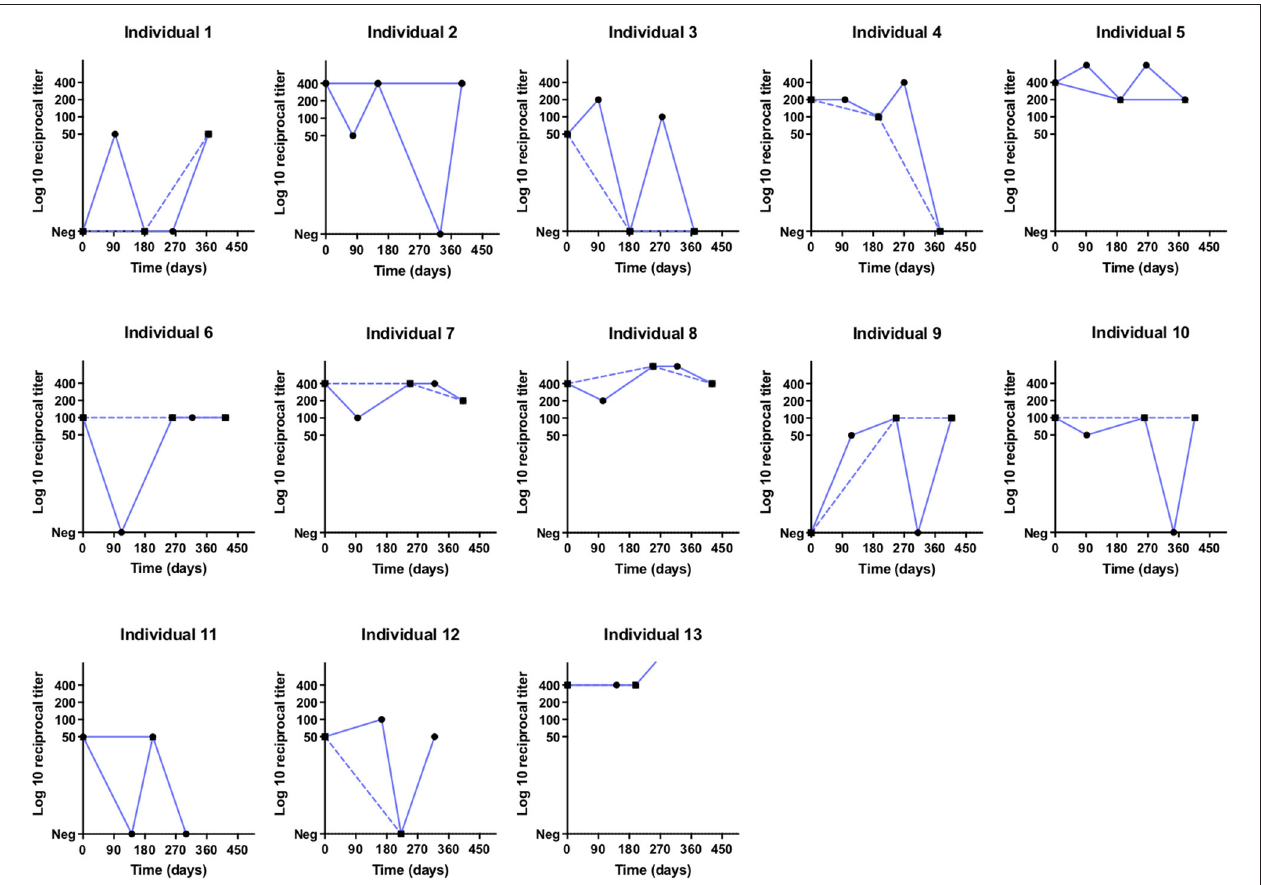
FIGURE 3 | Titration curves in log10 of individuals classified as reinfection in the quarterly analysis ( • ) and infection in the biannual analysis ( (cid:5) ) at different times (days) of